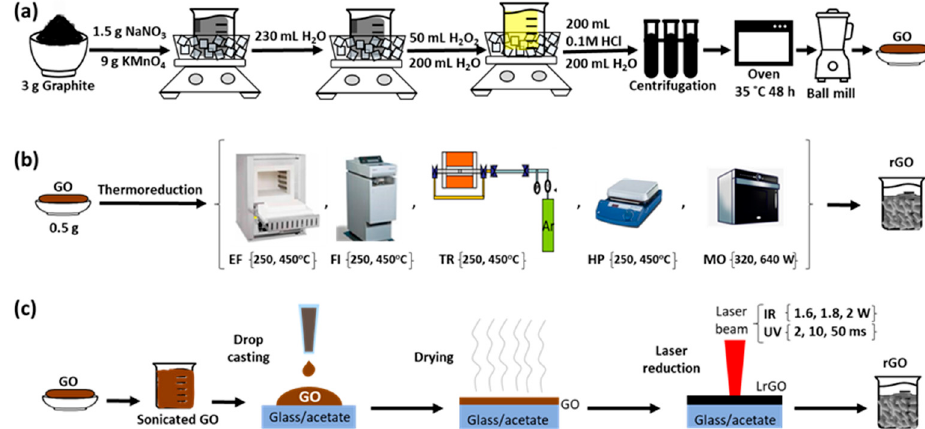
Figure 1. Schemes representing the process flow of the rGO preparation using ( a ) oxidation process, ( b ) thermal reduction and ( c ) laser reduction.